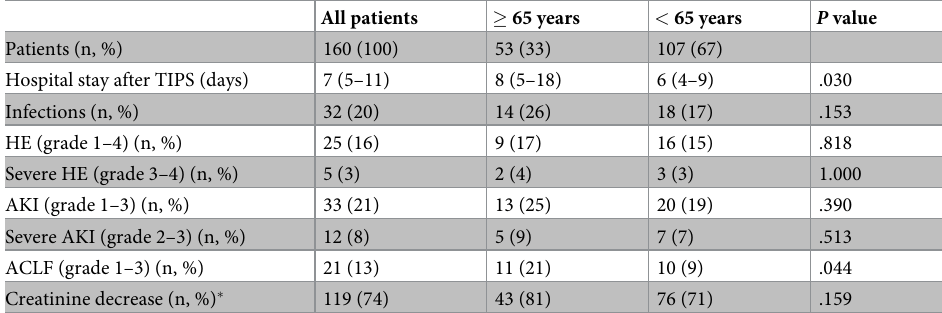
Table 2. Periinterventional course during hospital stay after TIPS insertion. All